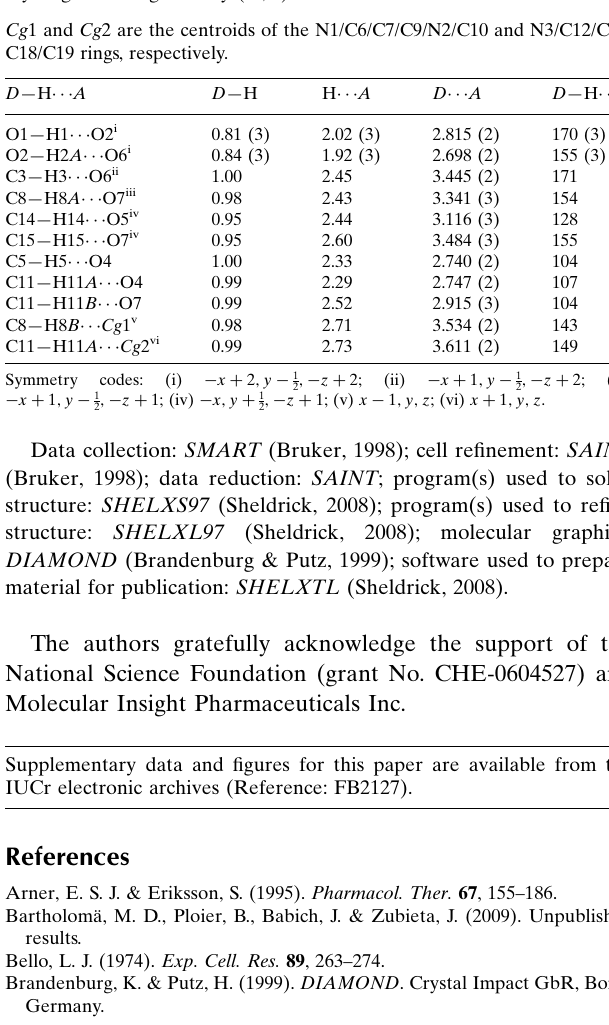
Hydrogen-bond geometry (A˚ , (cid:2)